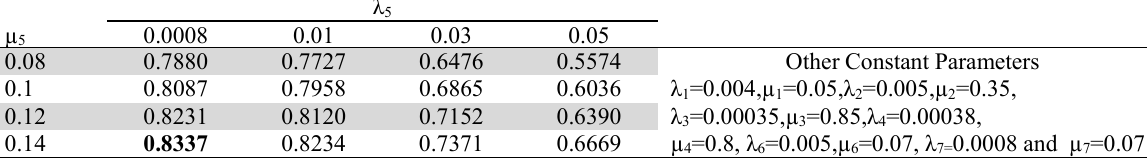
Effect of failure and repair rates of bottle washer on system availability λ 5